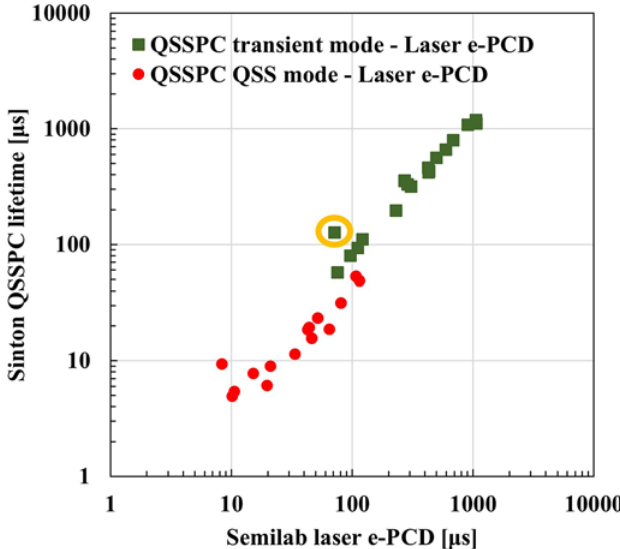
Fig. 9. Comparison of lifetime values obtained using QSSPC and laser e-PCD techniques. Correlation to QSSPC is excellent in its transient mode. The circled out-of-trend value corresponds to a sample featuring especially strong ILD. The large discrepancy between the QSS and transient mode evaluation indicates the importance of the capability of laser e-PCD providing uni fi ed transient mode evaluation in the entire lifetime